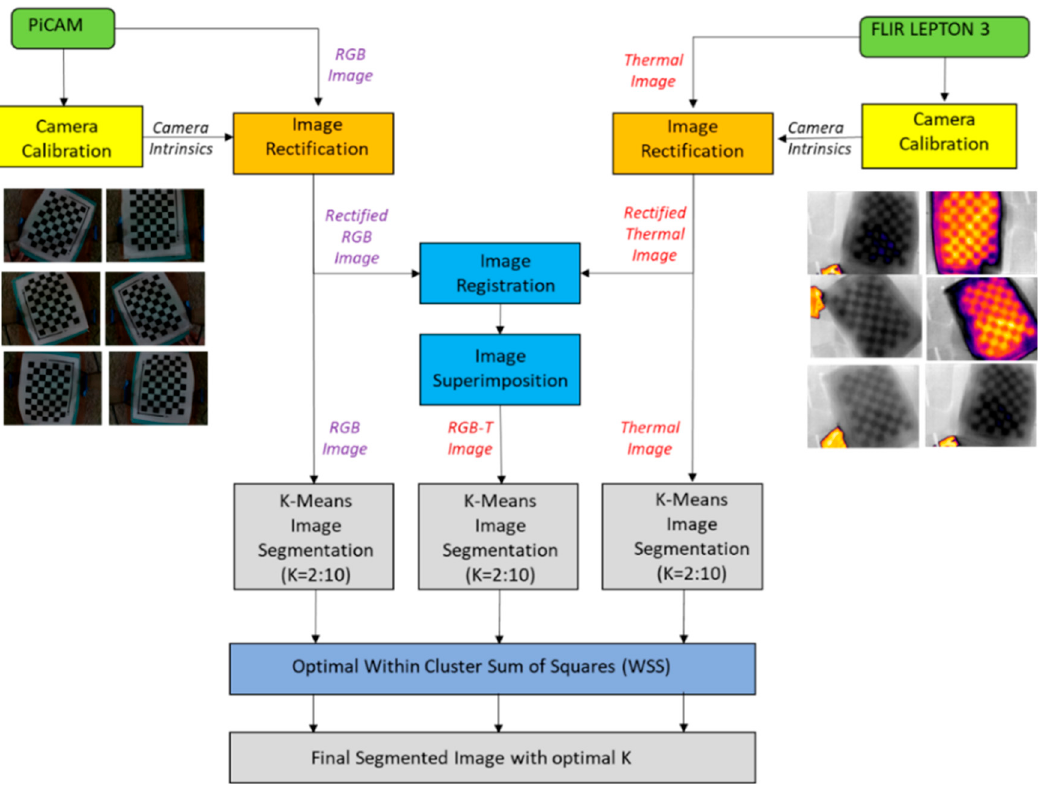
Figure 3. Proposed system framework for acquisition and processing of RGB, thermal and RGB-T images.